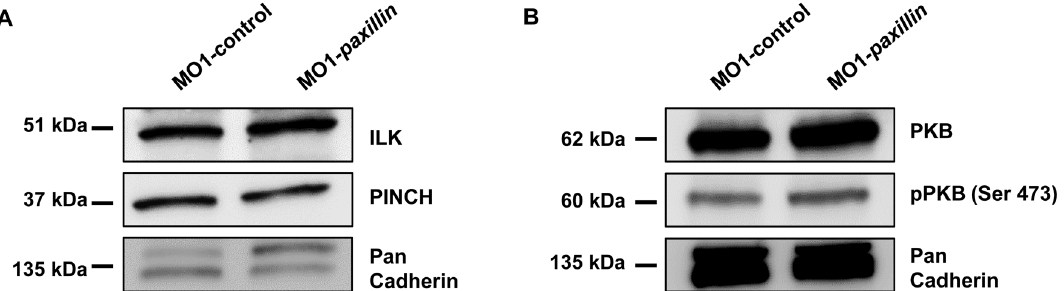
Fig 2. Paxillin does not regulate IPP-complex stability and PKB activation in zebrafish. (A) Western blot analysis of Paxillin morphant protein lysates compared to lysates obtained from control-injected embryos with antibodies against ILK and PINCH. For each sample 50 embryos were pooled and 20 μ g of protein lysate were loaded per lane. The figure shows one representative western blot out of three independent experiments. (B) Western blot analysis of protein levels of total PKB and serine 473-phosphorylated PKB in MO1- paxillin -injected embryos. For each sample 50 embryos were pooled and 20 μ g of protein lysate were loaded per lane. The figure shows one representative western blot out of three independent experiments.